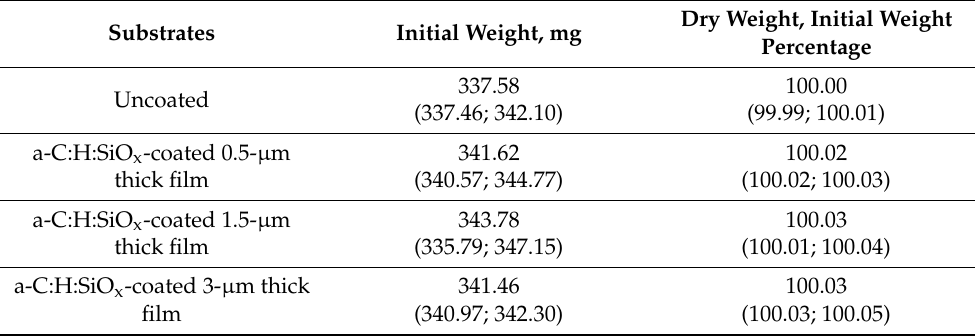
Table 3. Ti-6Al-4V substrate weight before and after five-week in vitro biodegradation in 0.9% NaCl solution, Me ( Q 1; Q 3), n 1 =